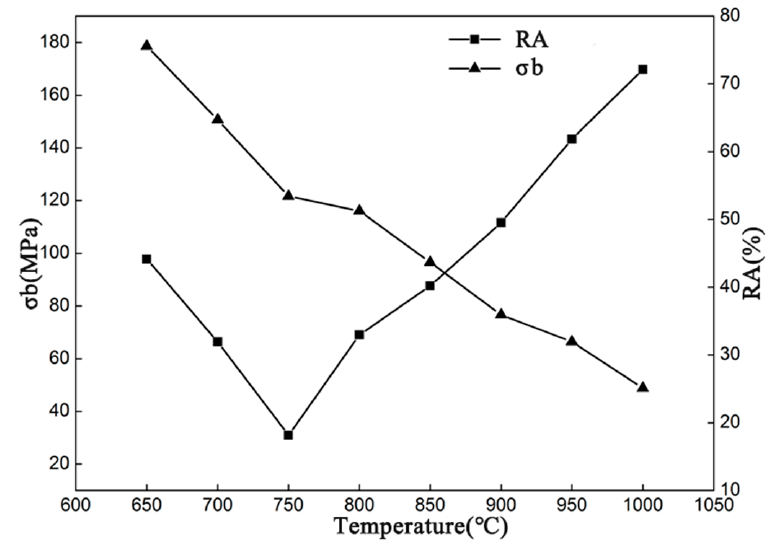
Figure 8. Measured hot ductility and tensile strength of S355 steel.